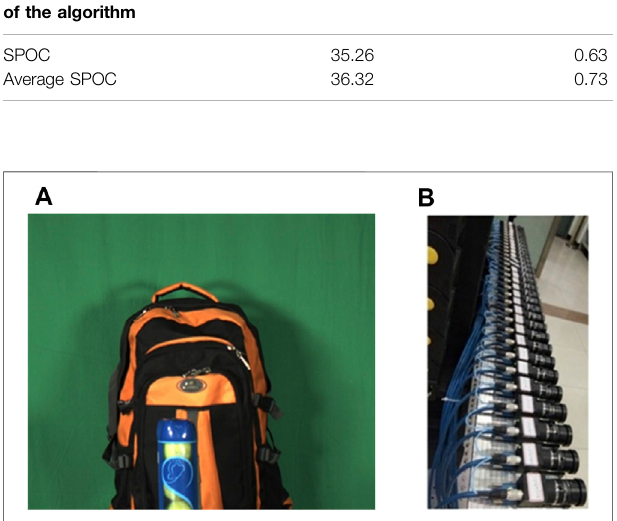
FIGURE 11 | (A) Real three-dimensional scene. (B) Camera array.